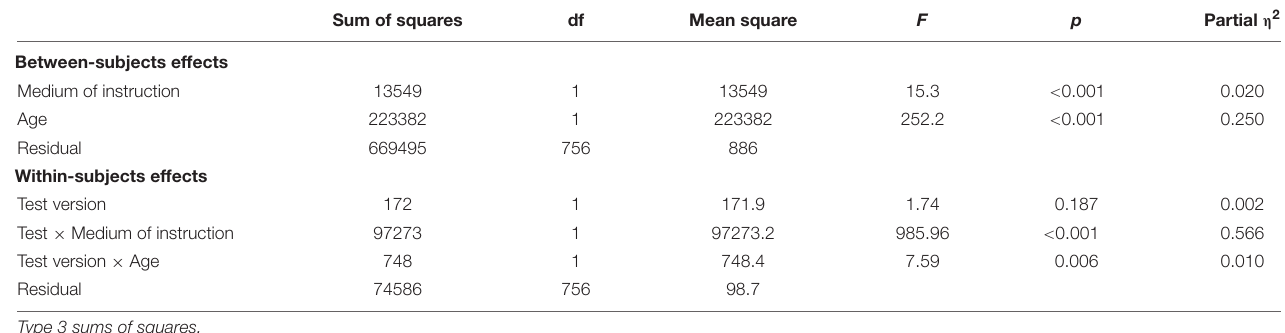
TABLE 1 | Repeated measures ANOVA: Rate of reading. Sum of squares df